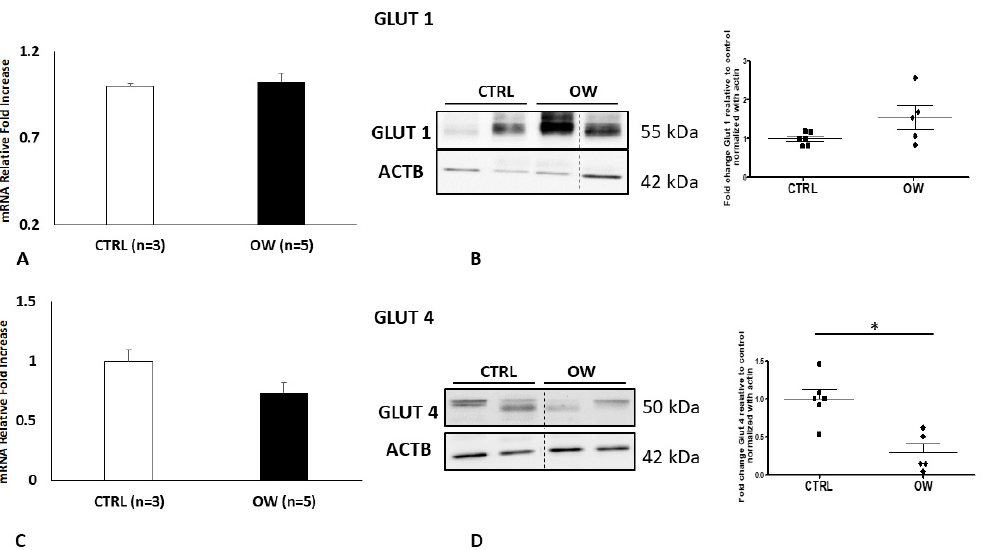
Figure 2. GLUT 1 and 4 expression ( A , C ) and protein levels ( B , D ) in placenta explants from normal ( CTRL ) and over- weight ( OW ) women. ( A ) Fold Change of GLUT1 mRNA in normal ( n = 3) and overweight ( n = 5) placental explants. ( B ) Representative WB (left panel) and corresponding densitometry (right panel) of GLUT1 in placenta explants from CTRL ( n = 6) and OW ( n = 5) women. ( C ) Fold Change of GLUT4 mRNA in normal ( n = 3) and overweight ( n = 5) placental explants. ( D ) Representative WB (left panel) and corresponding densitometry (right panel) of GLUT4 in placenta explants from CTRL ( n = 6) and OW ( n = 5) women. Data are presented as mean ± ES. Significance was determined using an unpaired two-sided t -test. * p < 0.05.